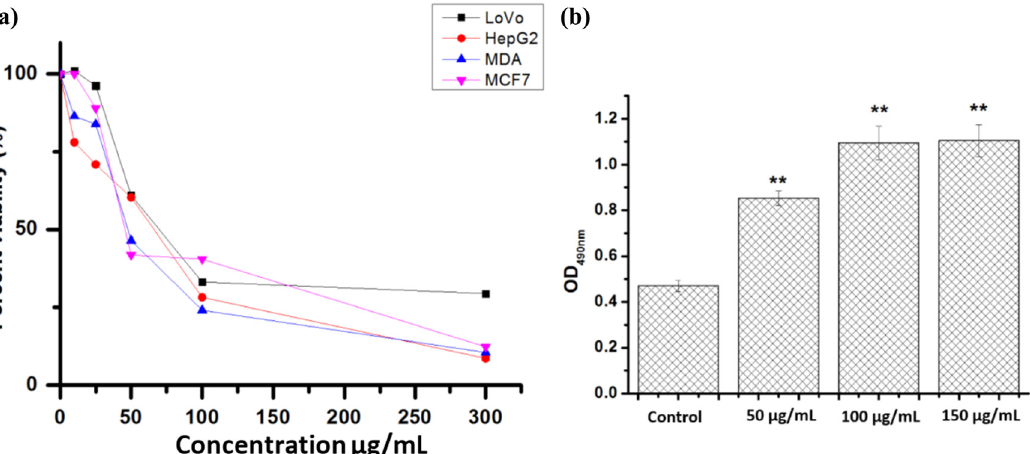
Figure 1: In vitro cytotoxic activity of the PHF5 methanolic extract against MCF7, MDA - MB 231, LoVo, and HepG2 cell lines. ( a ) Cytotoxicity ( % viability ) was measured by MTT assay. ( b ) LDH assay revealed cytotoxicity of the PHF5 methanolic extract against MCF7 cells. The results are presented as percentage of the control. Data are presented as mean ± SD of three independent experiments. **Statistically signi fi cant di ff erence compared with the untreated control ( Student ’ s t - test, P < 0.05 )